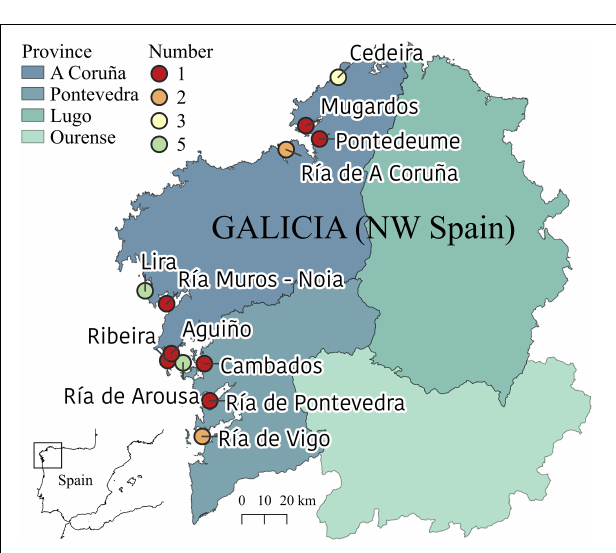
Interest (Fernández-Márquez, 2015; Tubío, 2015; Fernández- Vidal, 2017), and using private and/or public exploitation concessions to develop shellfishing activities for